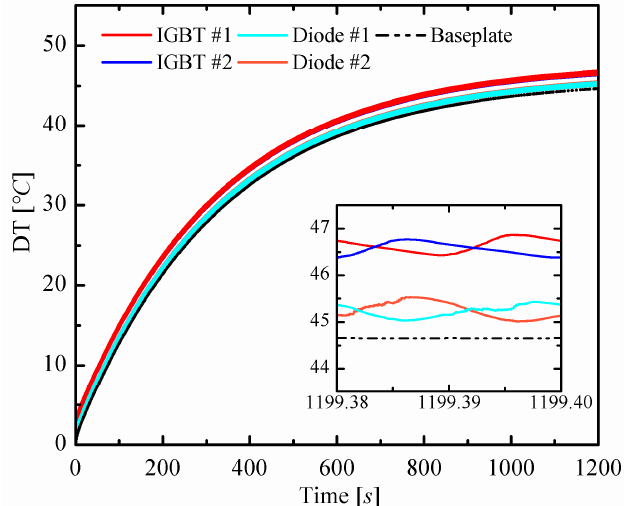
Figure 6. Estimated variation of IGBTs, diodes, and baseplate temperature rises for the module under test mounted on a 2.5 K/W heatsink. Details about the steady state response highlighting the temperature cycles are depicted in the inset.